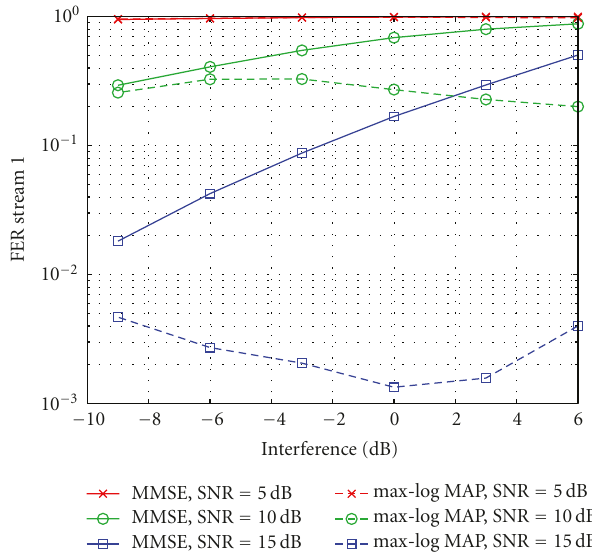
Figure 13: Frame error rate of the first stream of the of the MMSE and max-log MAP receiver for a frequency selective Rayleigh fading channel. CH2 has a frequency o ff set of 1500 Hz w.r.t. the receiver. Results are plotted for di ff erent SNR levels of the first stream. The x -axis denotes the interference of the second stream w.r.t. the first stream.